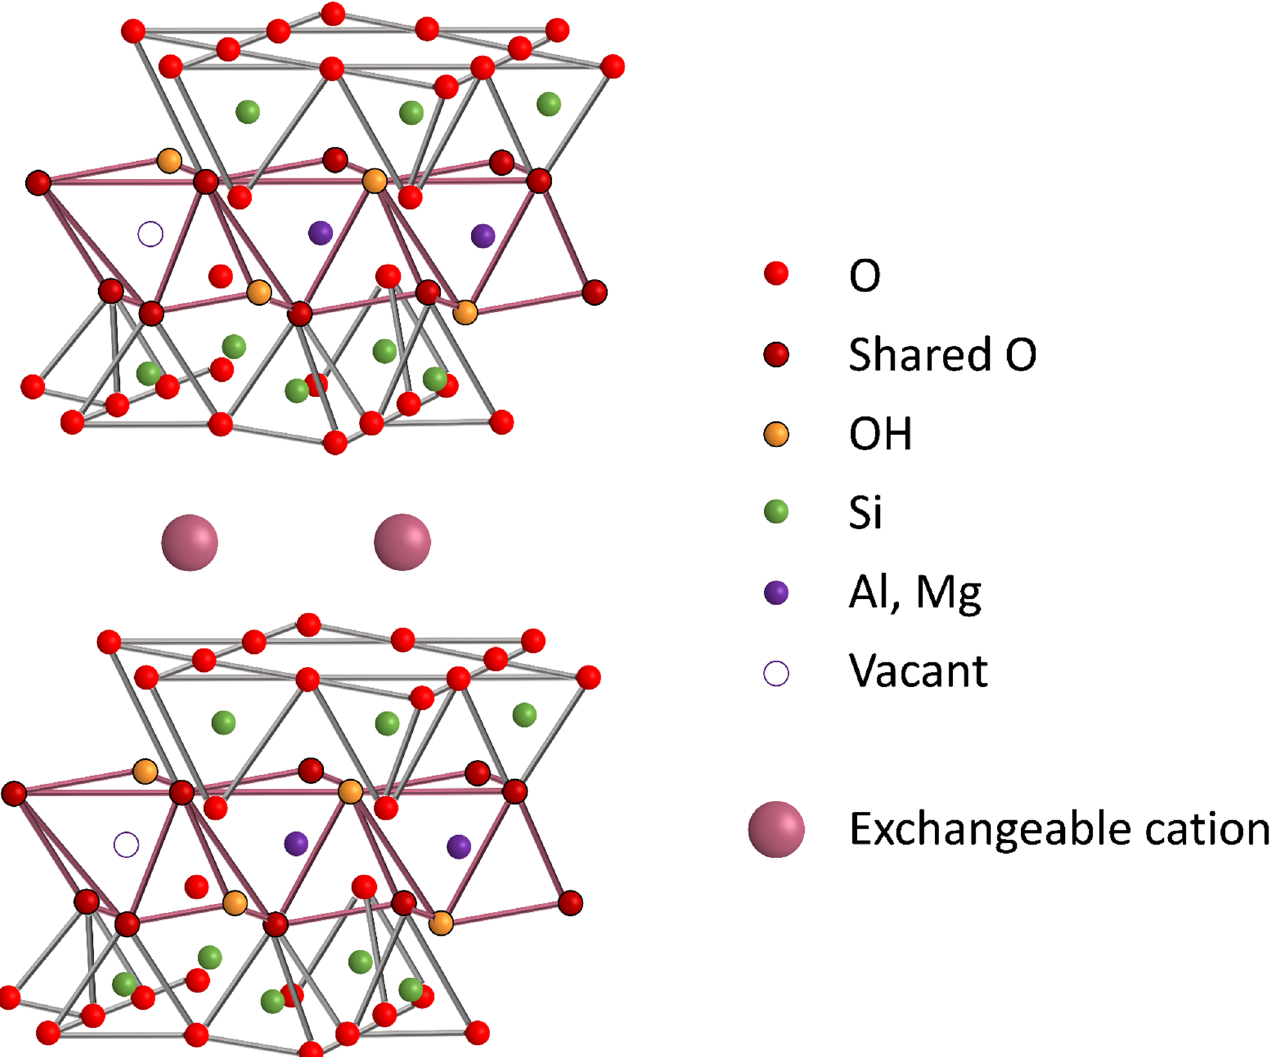
Scheme 1. Representation of the laminar structure of smectite-clays.